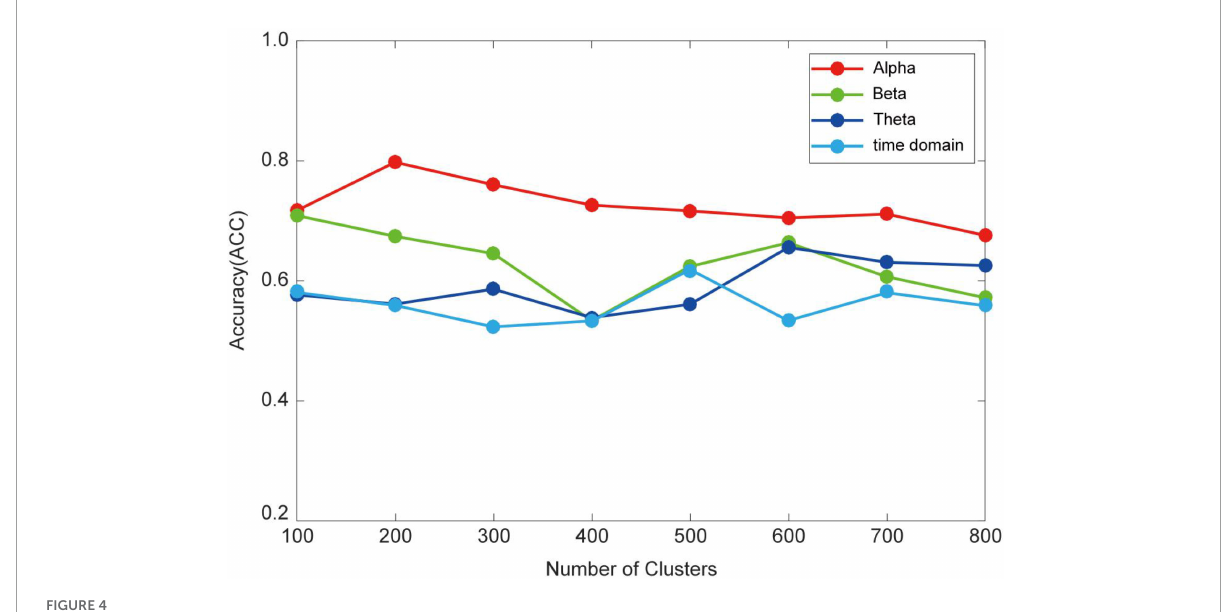
FIGURE4 Recognition accuracy of HO-BFN with different number of clusters.